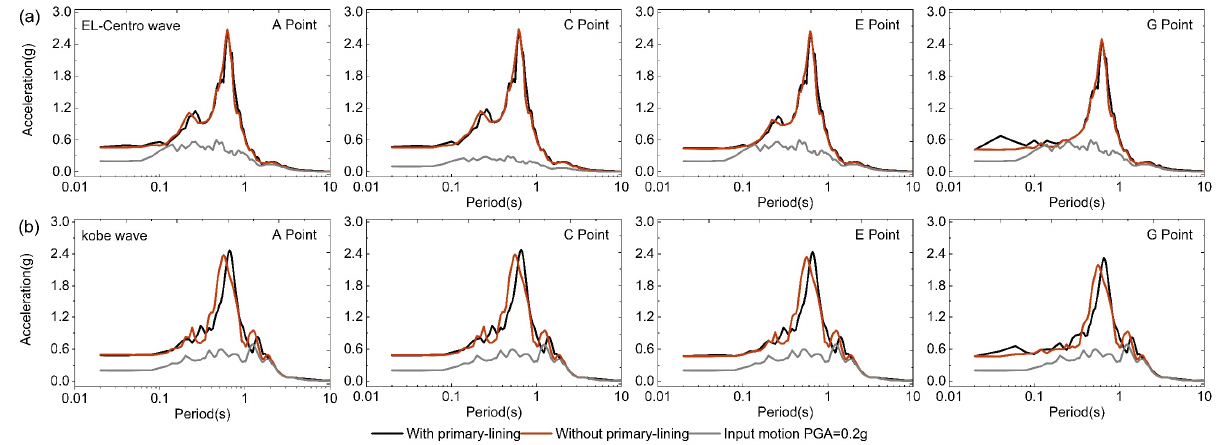
Figure 13. Acceleration response spectra at the important section of tunnel.